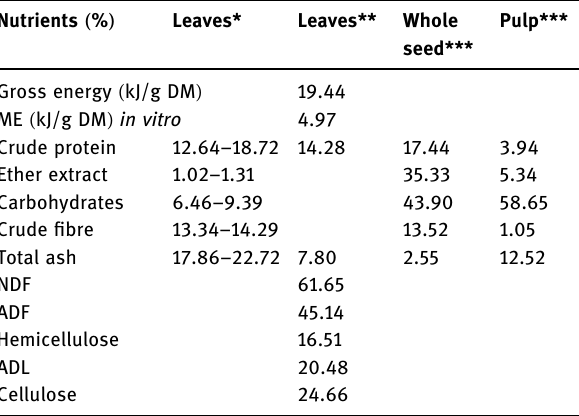
Table 1: Proximate composition of D. guineense leaves